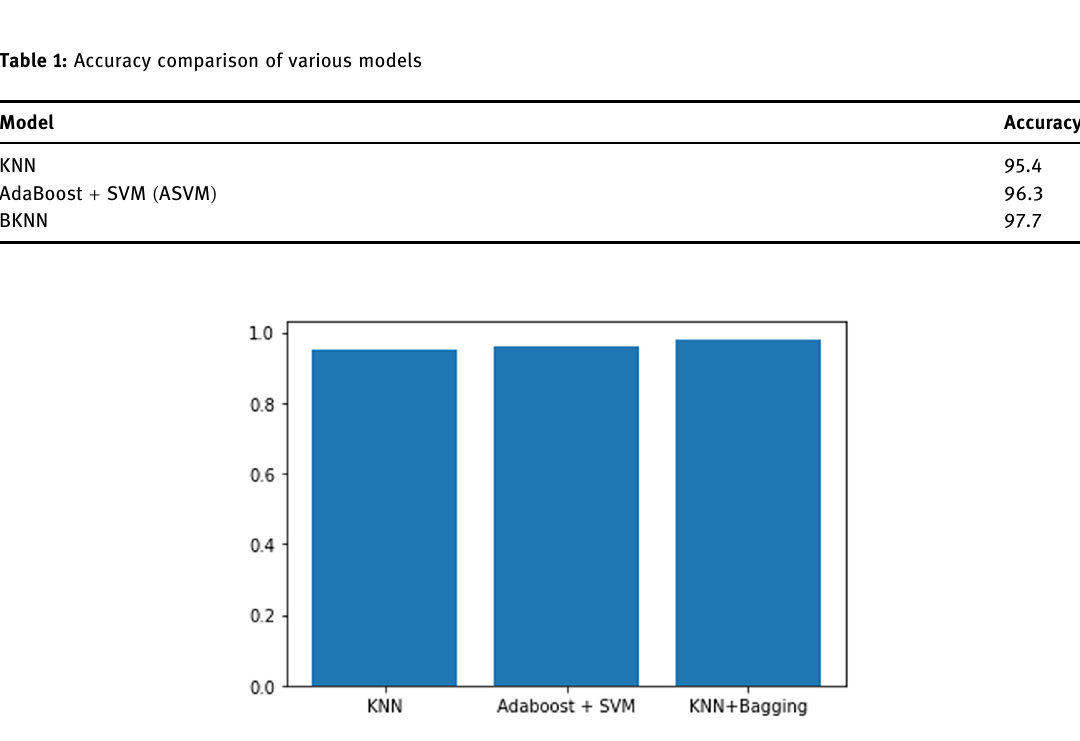
Figure 14: Accuracy comparison graph between KNN, AdaBoost and support vector machine ( ASVM ) , and